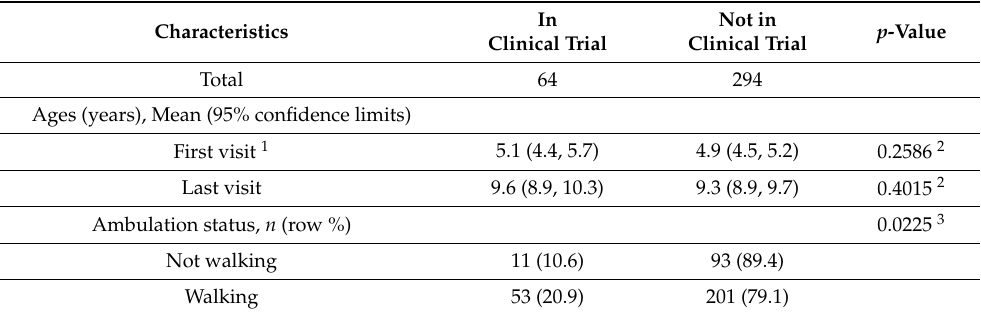
Table 3. Clinical characteristics by any clinical trial participation in the Muscular Dystrophy Surveil- lance, Tracking, and Research Network (MD STAR net ),